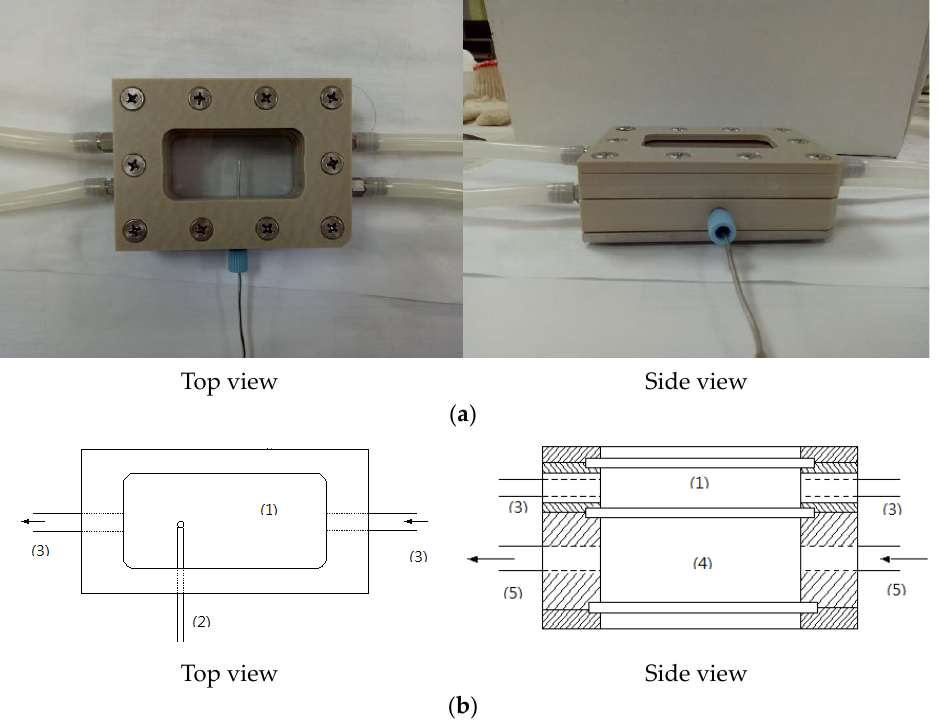
Figure 1. The photomicroscopic growth apparatus. ( a ) The real picture of growth cell; ( b ) schematic diagram of growth cell with the features: (1) solution chamber; (2) thermistor; (3) solution inlet and outlet; (4) constant-temperature water chamber; (5) water inlet and outlet.